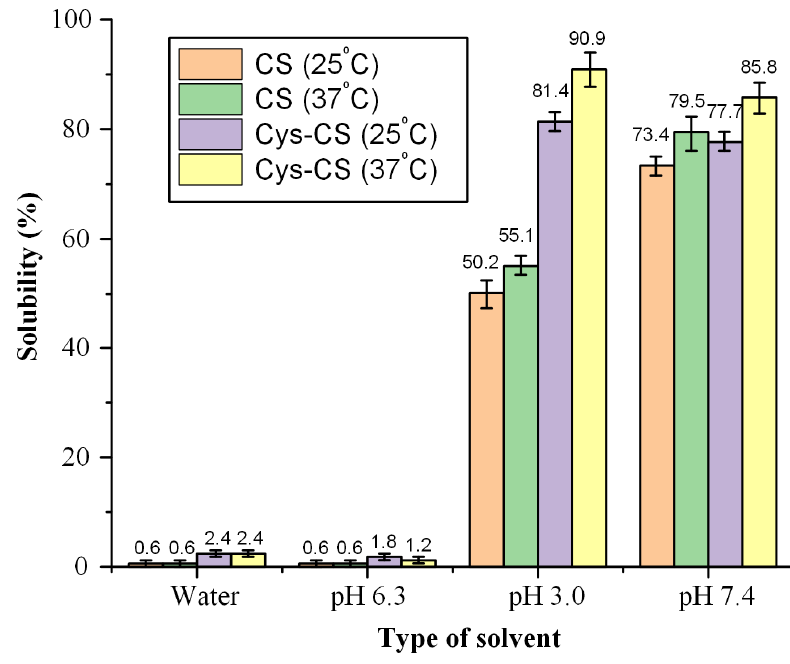
Figure 5. Solubility of CS and Cys-CS at 25 and 37 °C.